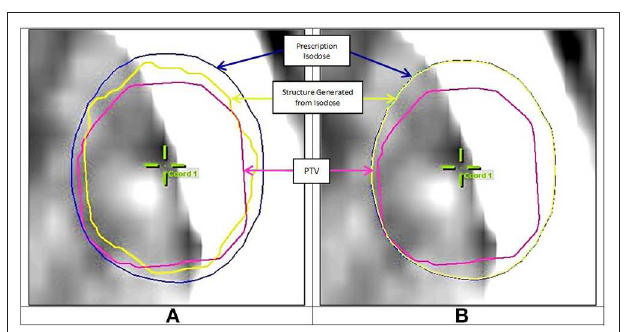
FIGURE 3 | (A) Mismatch between prescription isodose and iPlan generated structure, (B) Good match when using Velocity AI.